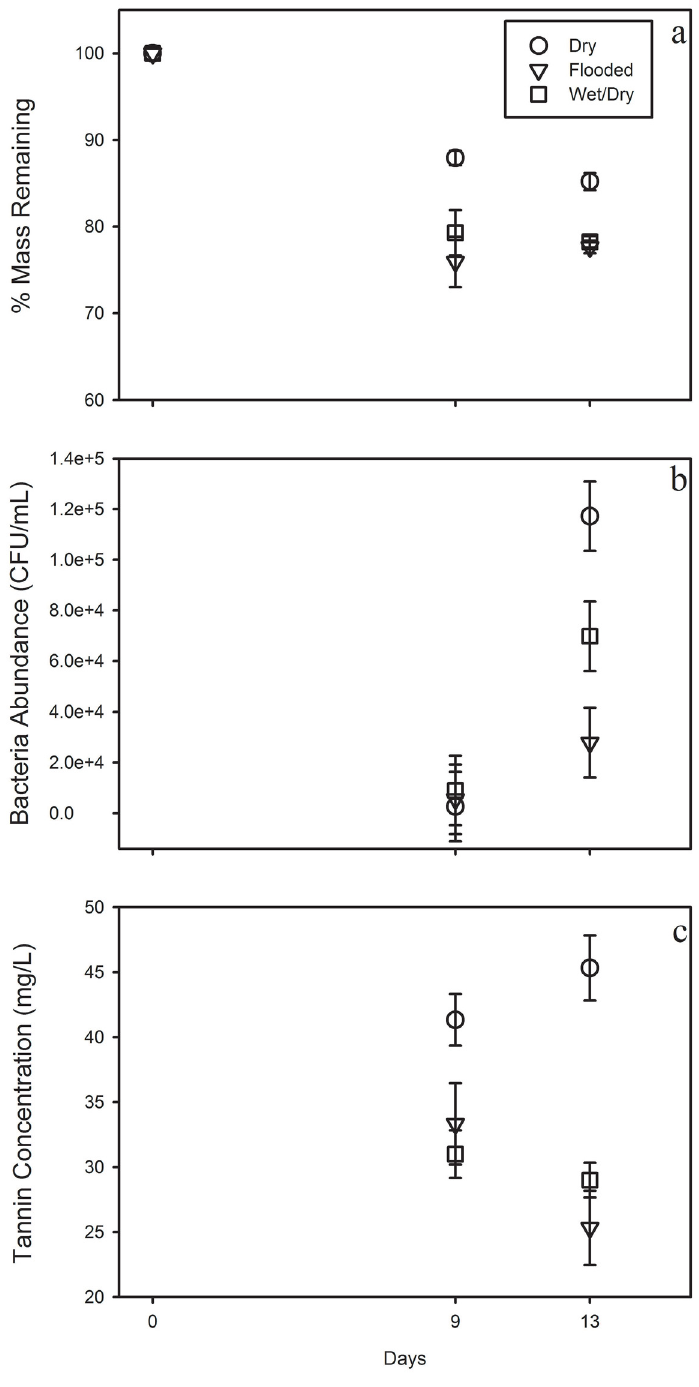
Fig 1. Water Quality Experiment Results. Quercus alba leaf litter (0.5 grams) was subjected to three hydrologic regimes: previously dried leaves, flooded leaves, and wet/dry leaves. Figures show differences among leaf litter in decay rate (a), bacterial abundance (b), and tannin concentration (c) as measured 9 and 13 days after inundation.